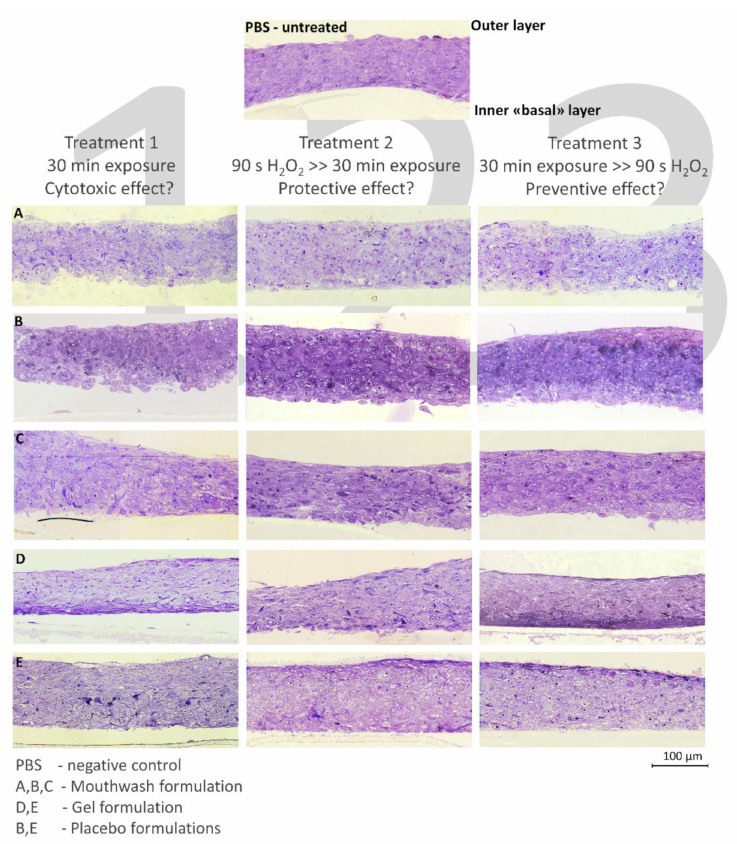
Figure 5. ( A – E ) Semi-thin sections of RHOE specimens. The outer layer of the epithelium is ori- ented upwards (Scale bar: 100 µ m). Each picture letter indicates treatment with the corresponding formulation, while each column represents one of the three treatments performed. Higher magnifica- tion fields were acquired, then photo-stitching and contrast optimization were performed to obtain high-resolution fields spanning the whole thickness of each